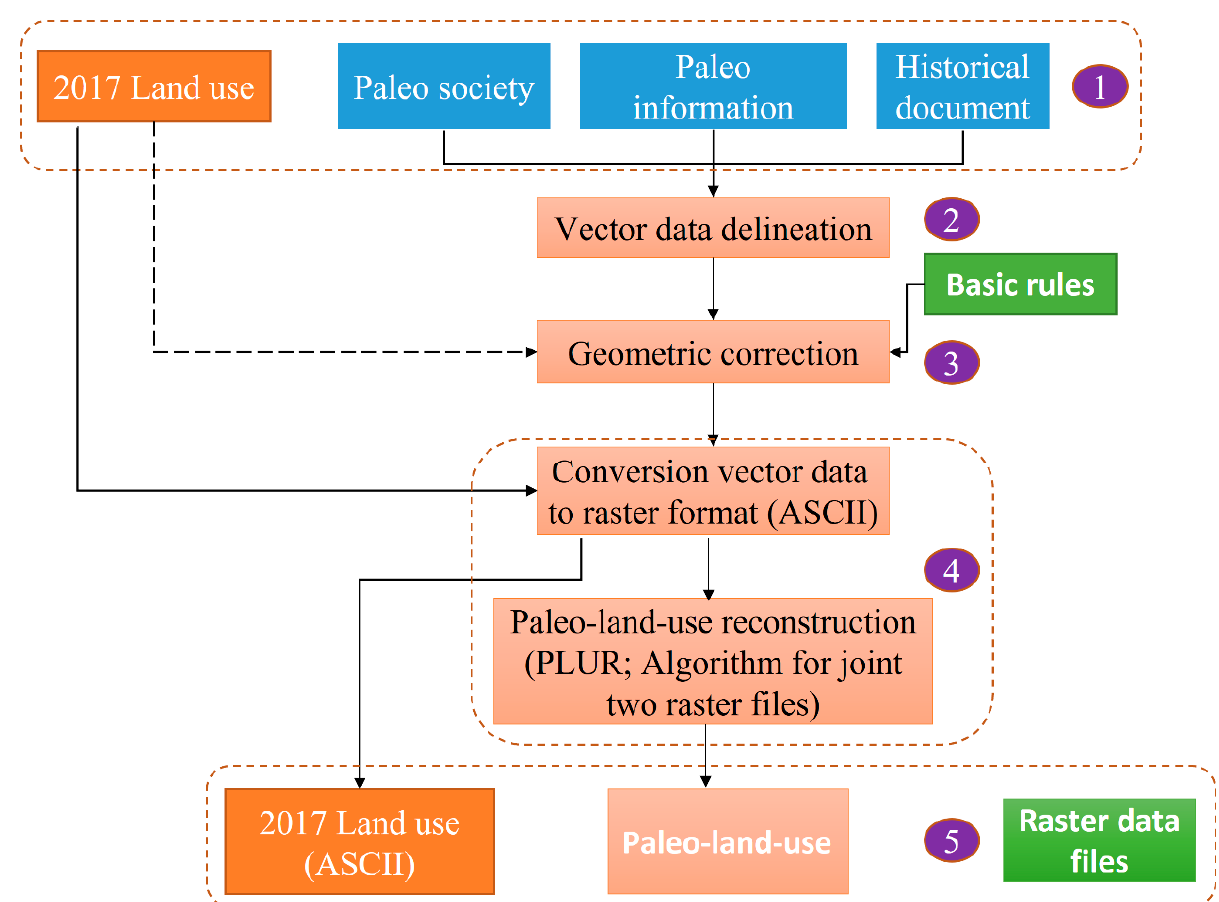
Figure 2. Historical Land-Use Reconstruction Process Using the PLUR Program.